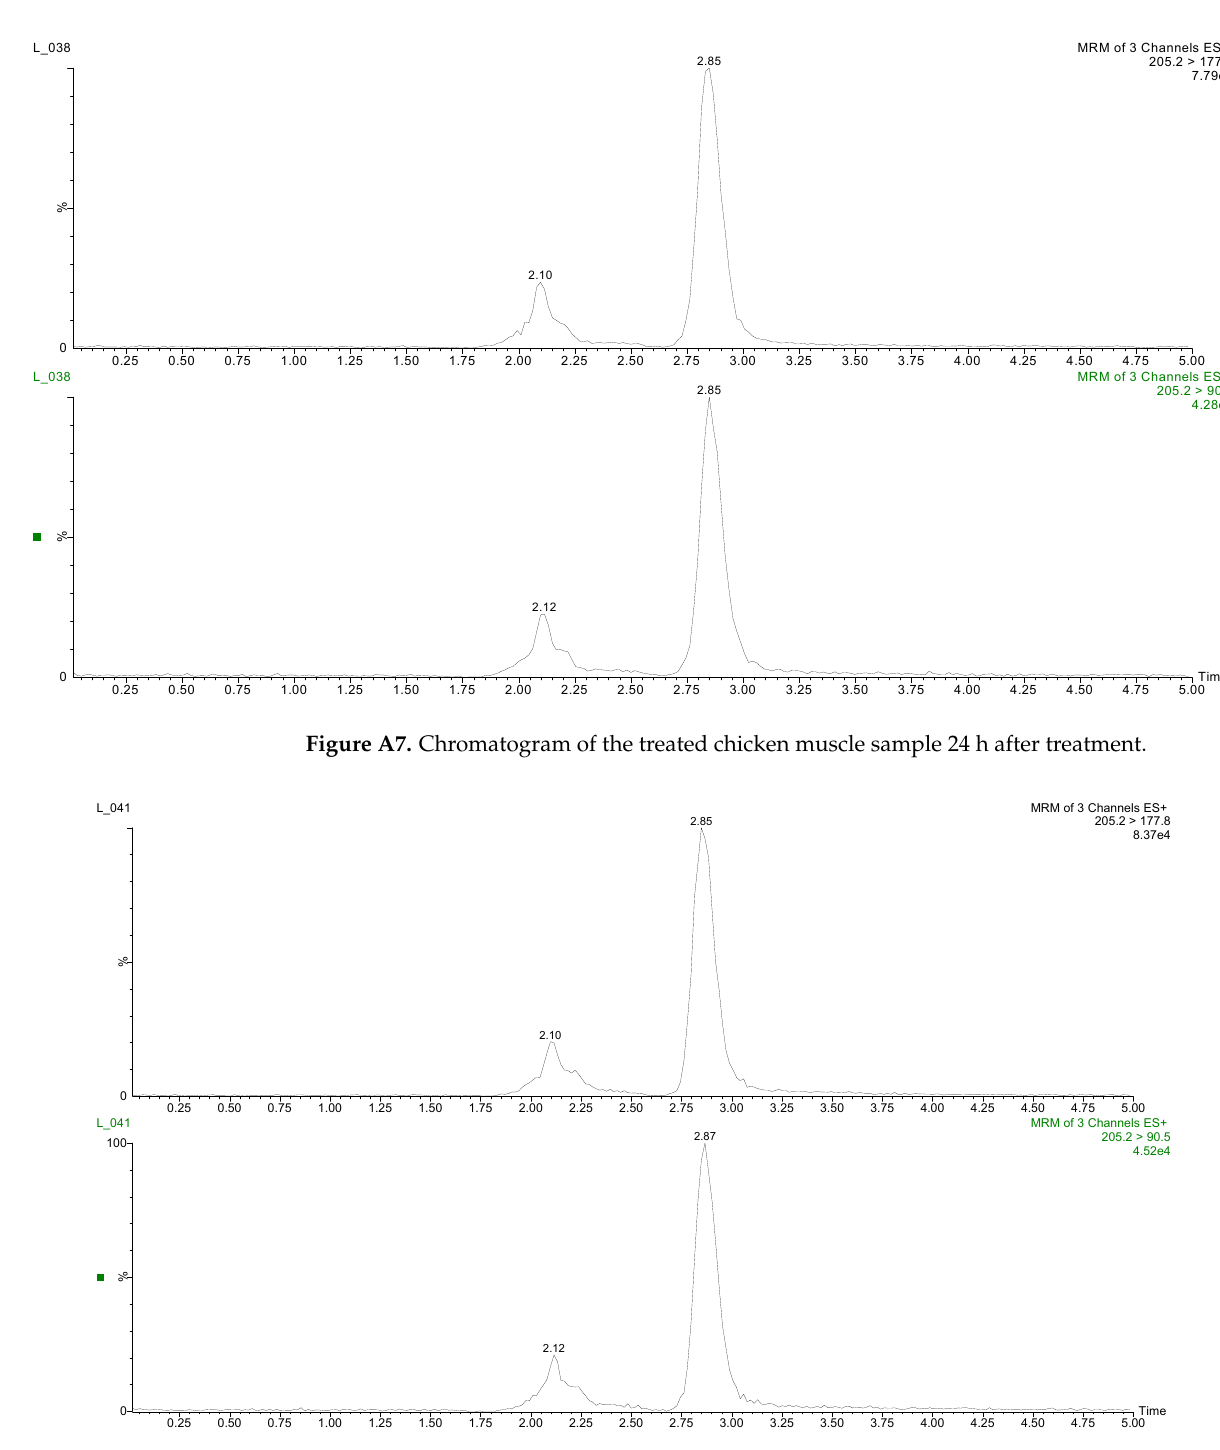
Figure A6. Chromatogram of the treated chicken liver sample 24 h after treatment.